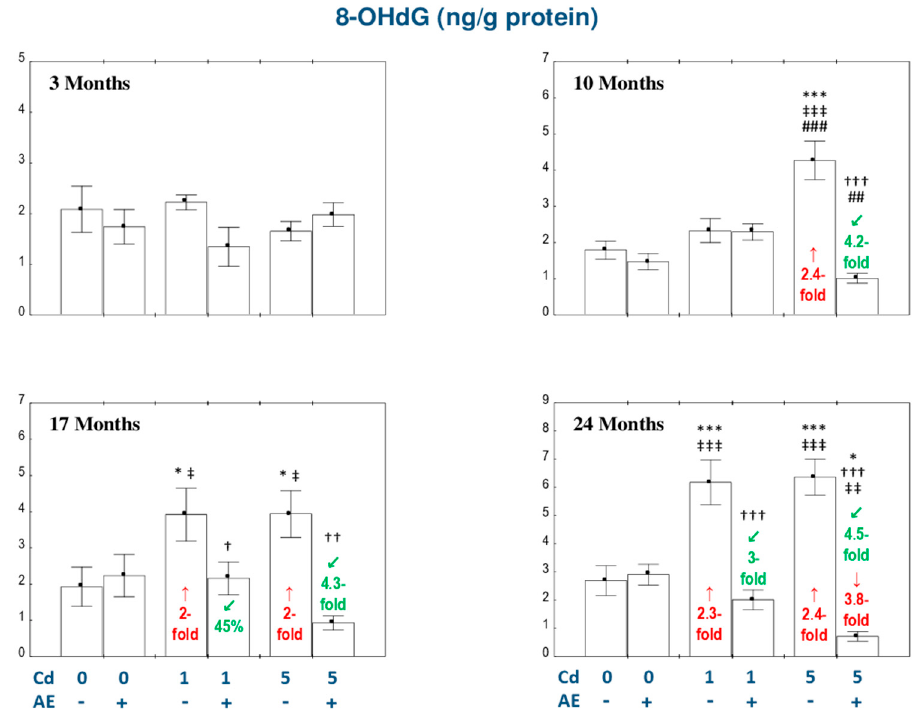
Figure 3. The influence of the extract from Aronia melanocarpa L. berries (AE) on the concentration of 8-hydroxy-2 ′ -deoxyguanosine (8-OHdG) in the liver of female rats exposed to cadmium (Cd). The females were given Cd in the diet at the concentration of 0, 1, and 5 mg Cd/kg and/or 0.1% aqueous AE (+) or not (-). Data are represented as mean ± SE for 8 animals, except for 7 females in the AE, Cd 1 , and Cd 5 groups after 24 months. Statistically significant differences (ANOVA, Duncan’s multiple range post hoc test): * p < 0.05, *** p < 0.001 vs. control group; † p < 0.05, †† p < 0.01, ††† p < 0.001 vs. appropriate group treated with Cd alone; ‡ p < 0.05, ‡‡ p < 0.01, ‡‡‡ p < 0.001 vs. group administered with AE alone; ## p < 0.01, ### p < 0.001 vs. appropriate group receiving the 1 mg Cd/kg diet (alone or with AE). Numerical values in bars or above the bars disclose the percentage changes or factors of changes in comparison to the control group ( ↑ , increase; ↓ , decrease) or the appropriate group given Cd alone ( ↙ , decrease).